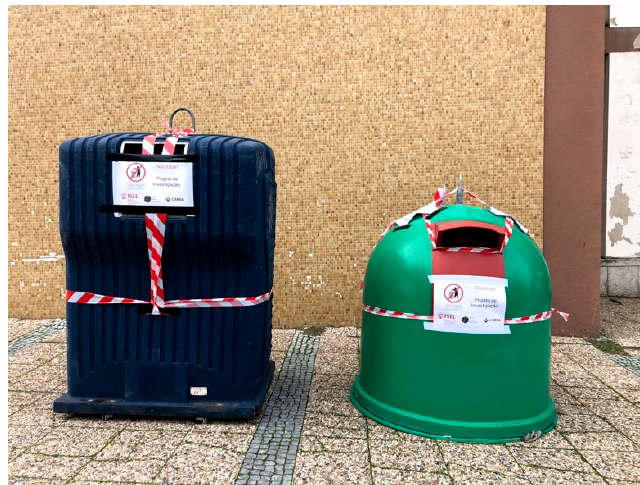
Figure 6. Cyclea (blue) and Iglô (green) containers installed at ISEL.